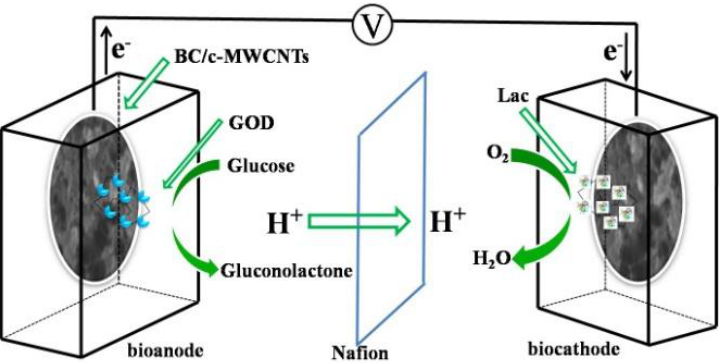
Figure 1. Illustration of the EBFC equipped with 3D BC/c-MWCNTs hybrid electrodes (not to scale).